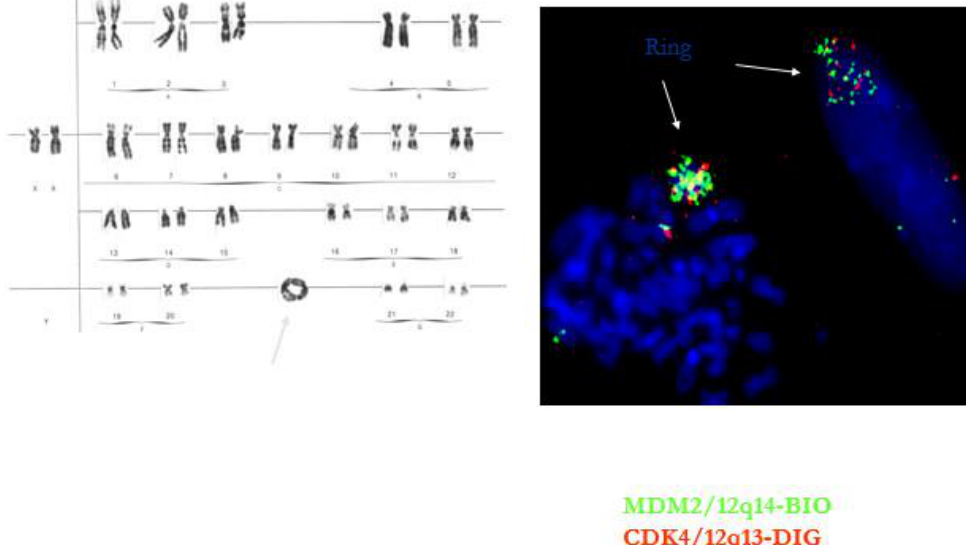
Figure 4. Ring chromosome in well-differentiated liposarcoma/atypical lipomatous tumor. The ring contains multiple copies of the MDM2 and CDK4 gene.